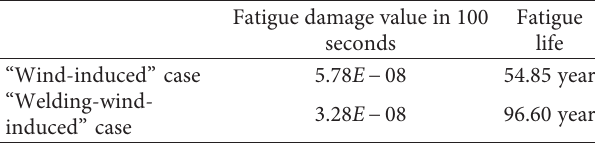
Table 3: Fatigue damage value and fatigue life at critical